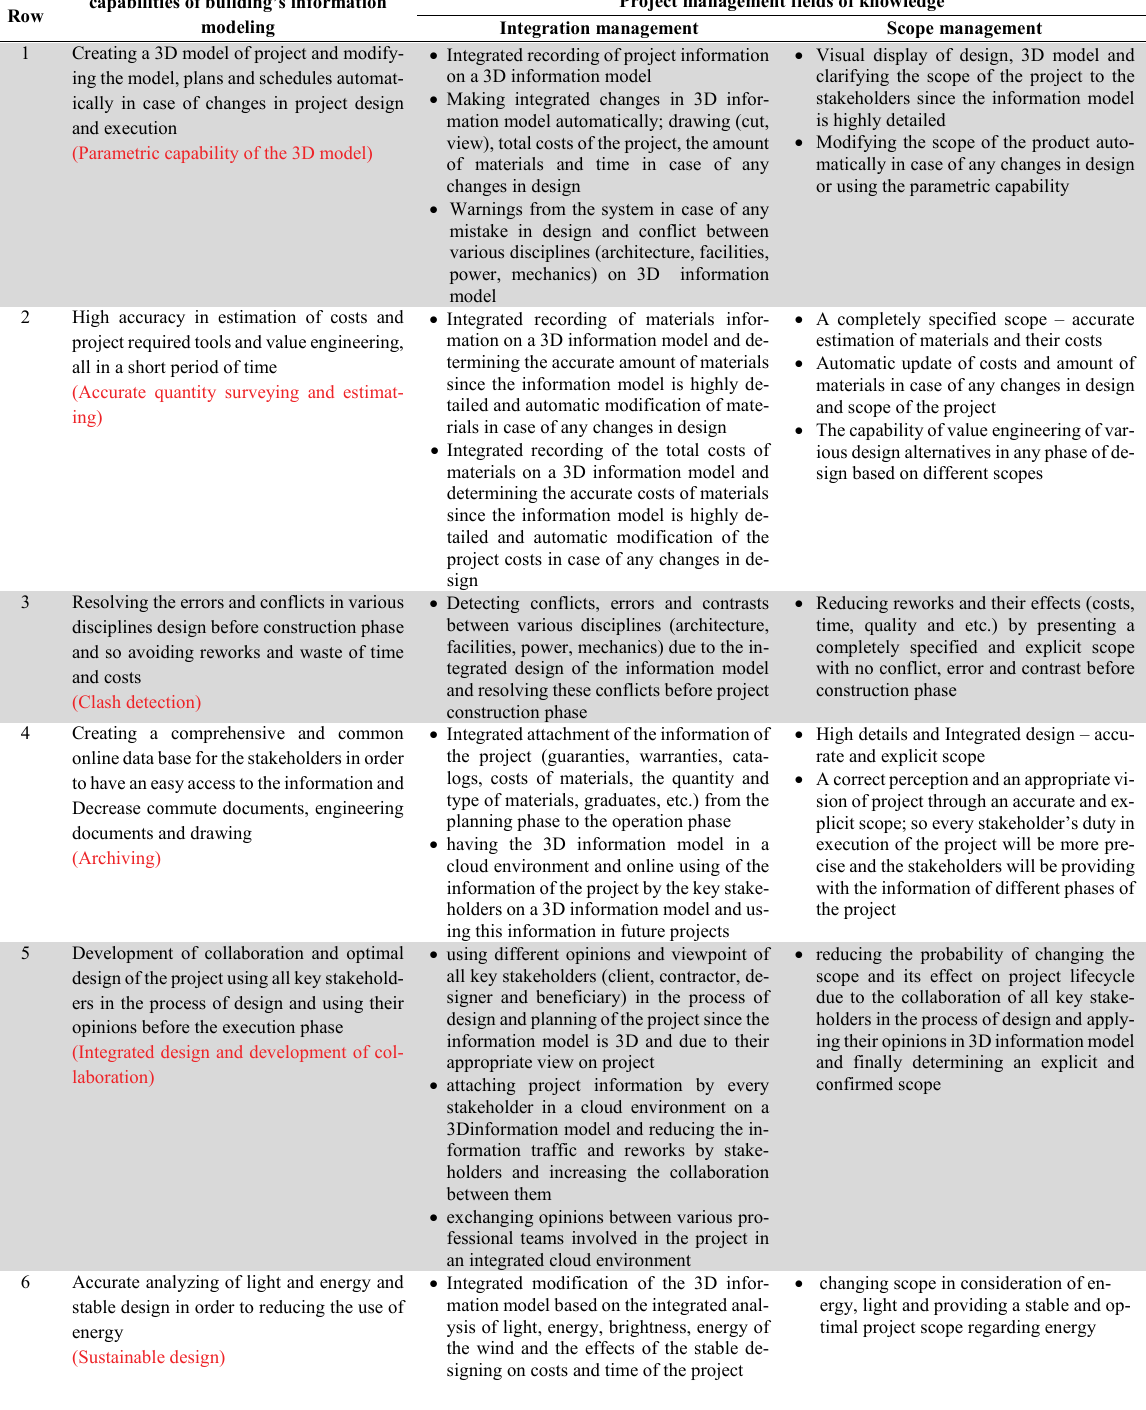
The effect of the capabilities of BIM on project management fields of